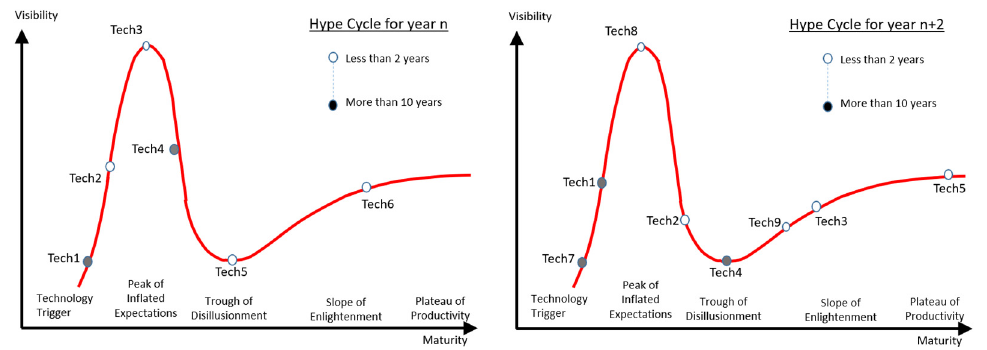
Figure 4. Gartner ‘hype cycle’ model .